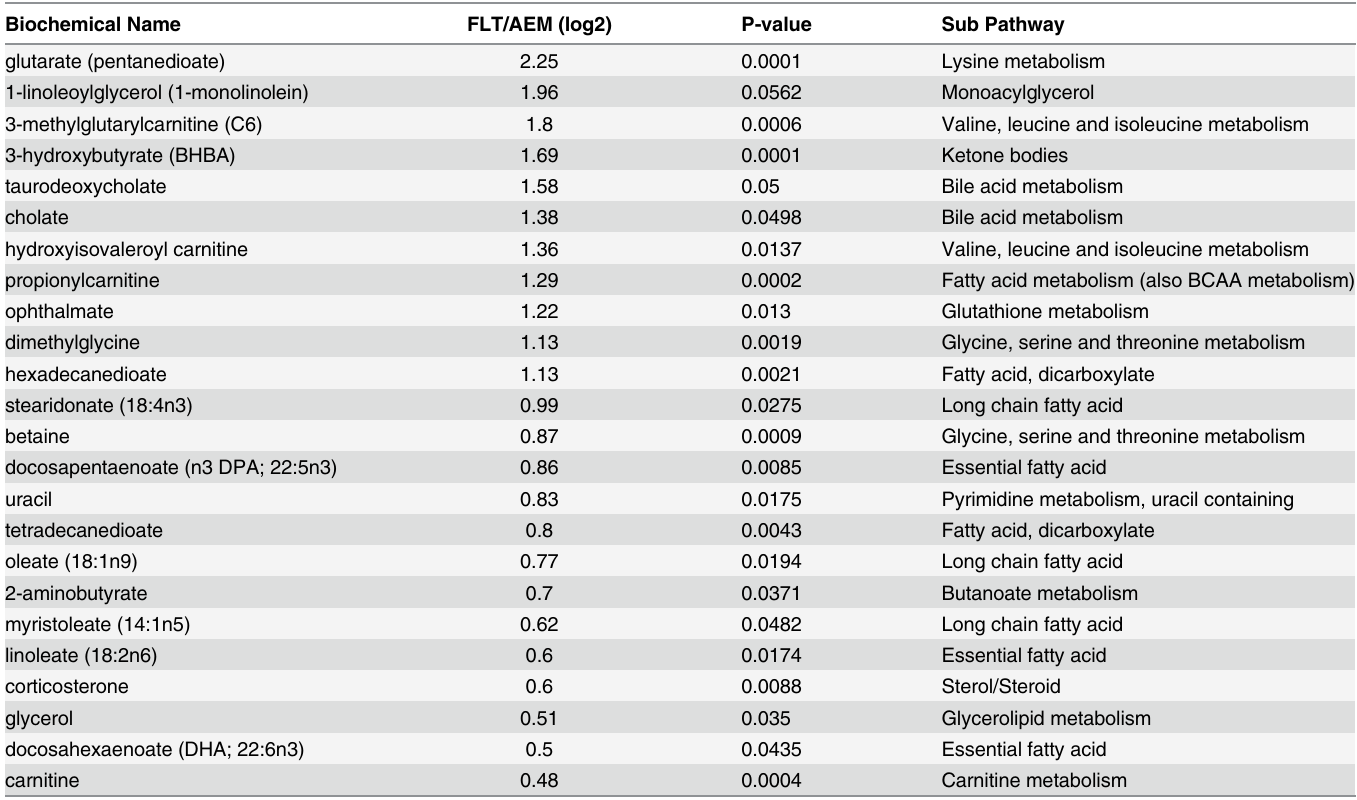
Table 3. Hepatic metabolites with increasing concentrations in spaceflight. Biochemical